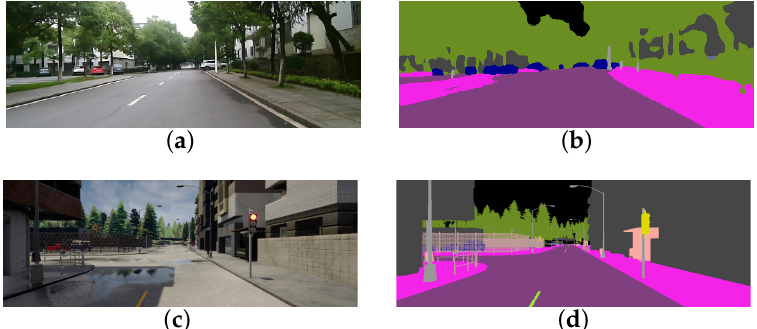
Figure 2. The comparison between the raw images and the semantic segmentation images. ( a ) is the raw image in the real environment, and ( b ) is the semantic segmentation image of ( a ). ( c ) is the raw image in the virtual environment, and ( d ) is the semantic segmentation image of ( c ). It can be clearly seen from the figures that the gap between the raw images of different environments is large, and the semantic segmentation image is an image obtained by coloring each type of element in the raw image uniformly, so the gap between the two is relatively